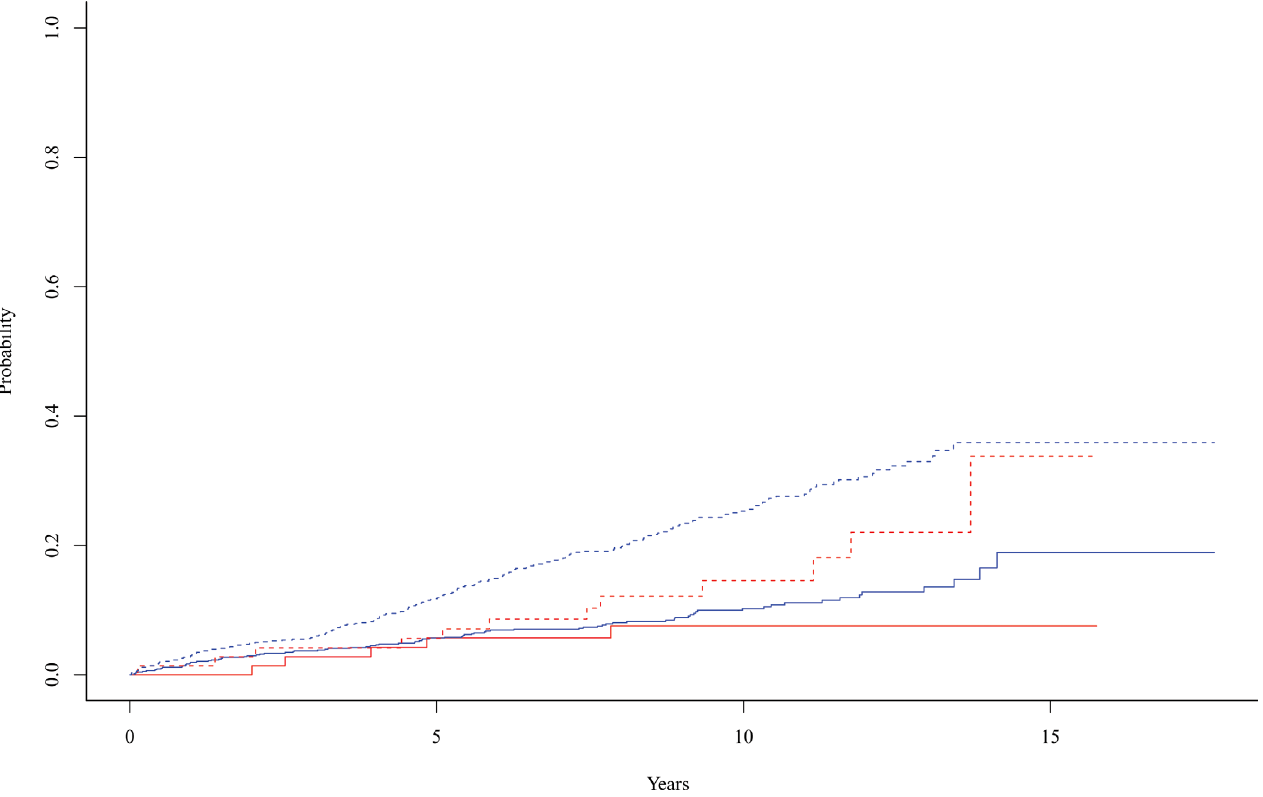
Fig 1. Incidence functions. Cumulative incidence functions for the two competing endpoints “ stroke first ” (solid line) and “ death first ” (dotted line) according to the presence (red) or absence (blue) of APC resistance.